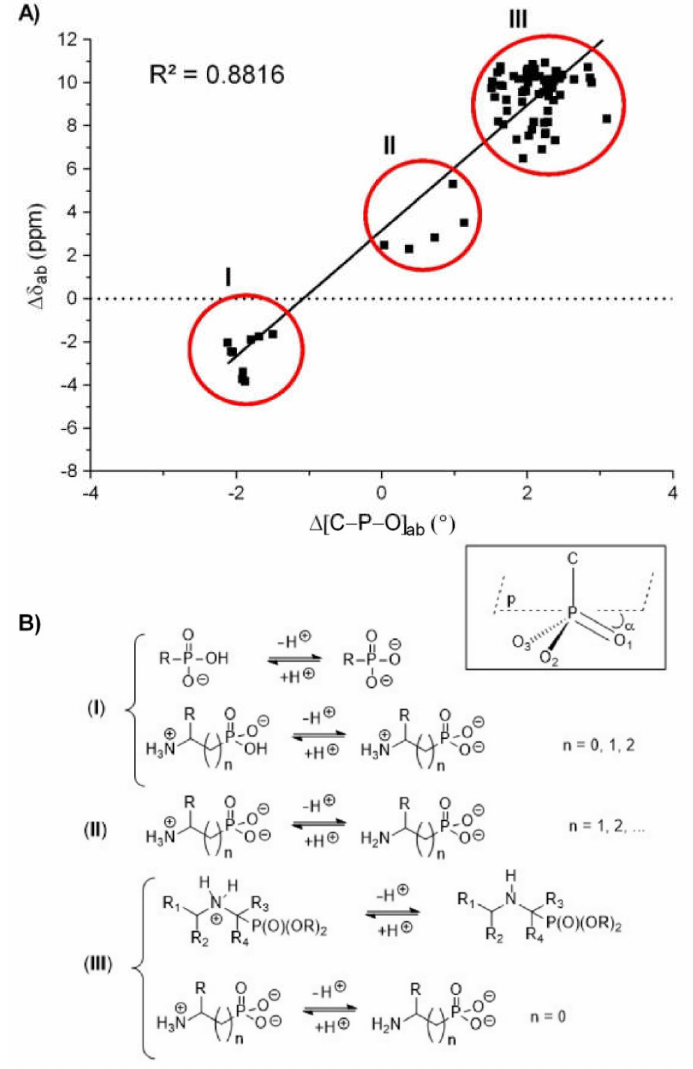
Figure 5. ( A ) Plot of 31 P NMR sensitivity against ab initio calculated pyramidalization angles at phosphorus between the acidic and basic forms of a series of phosphorylated pH probes. Circled regions I to III visualize increasing pH probing properties. ( B ) Proton exchange reactions on (I) the O atom of phosphonic or aminophosphonic acids, (II) the N atom of aminophosphonic compounds with at least two carbons between the N and P atoms and (III) the N atom of aminophosphonates or aminophosphonic acids with only one carbon between the N and P atoms. Inset : Pyramidalization angle α